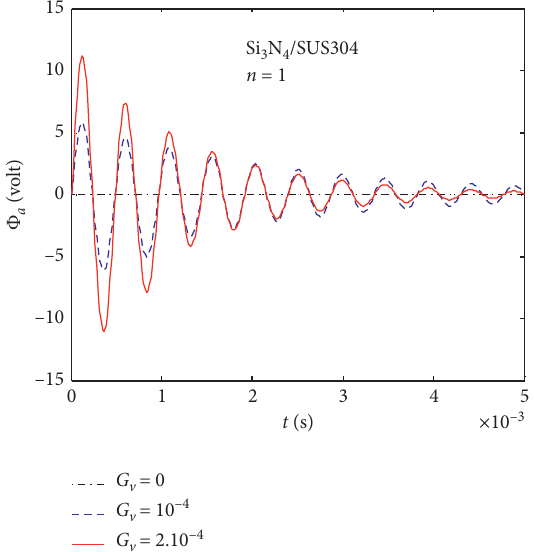
Figure 6: The dependence of ϕ